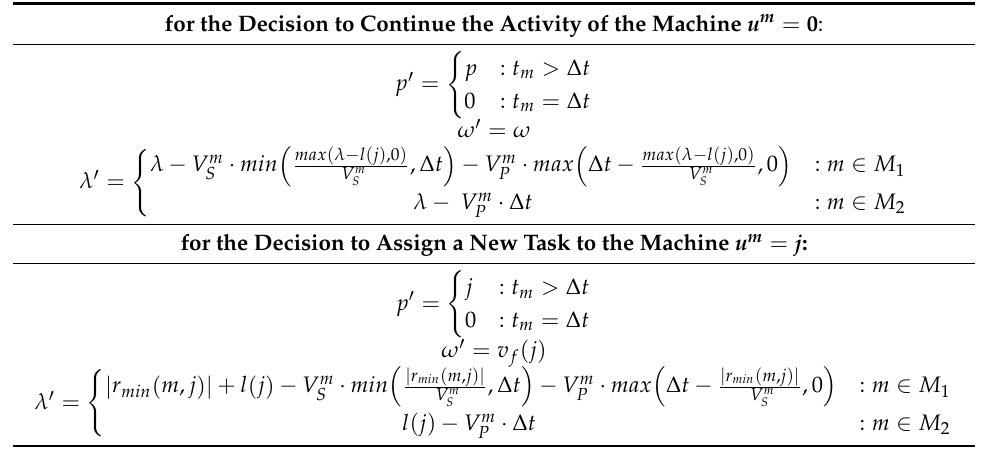
Table 1. Particular parameters of the coordinate of the new machine